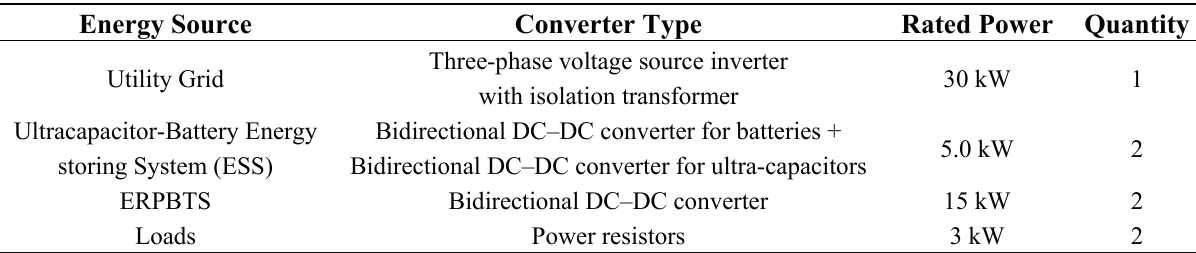
Table 2. List of the all the terminals used in experiments.